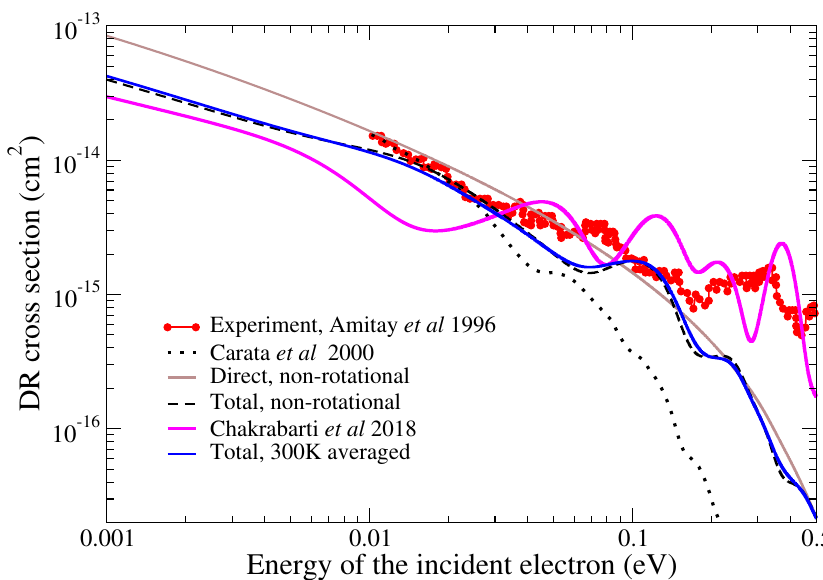
Figure 5. Comparison of Maxwell anisotropic convoluted cross section for the dissociative = 0 with experimental measurement. recombination of CH + ( X 1 Σ + ) in the ground vibrational state v + i Brown thin curve direct process without rotation, black dashed curve: total process without rotation, black solid curve: total process rotation included, black dotted line: MQDT calculation of Carata et al. [13], red curve: experimental results of Amitay et al. [11], thick magenta line: most recent three cores MQDT calculations without rotation